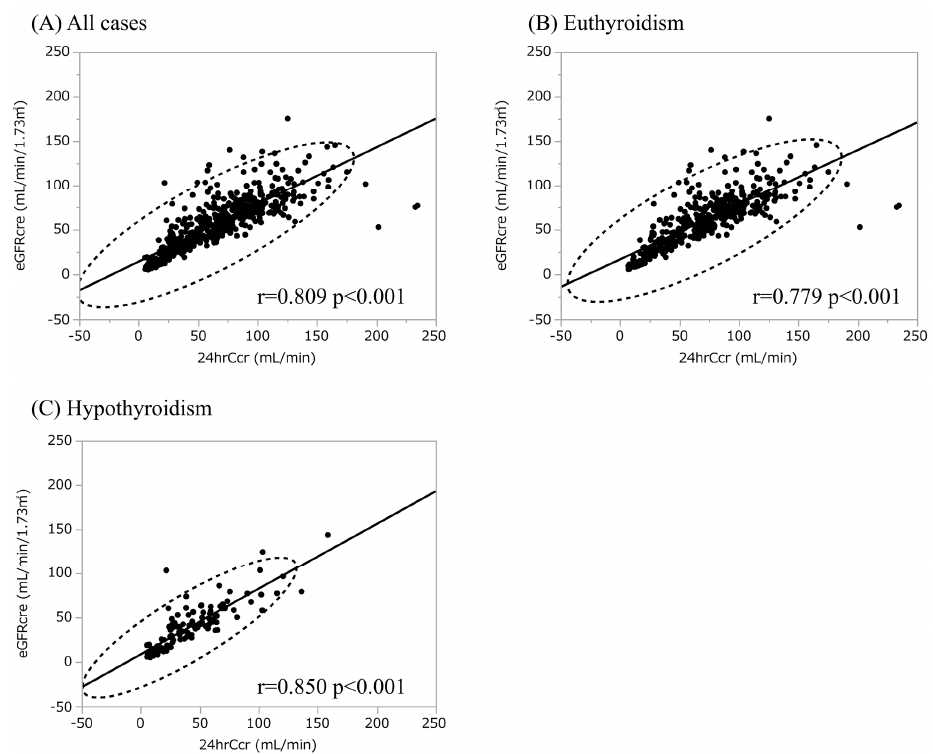
Figure 3. The association between eGFRcre and 24hCcr. ( A ) The association between eGFRcre and 24hCcr in all cases. ( B ) The association between eGFRcre and 24hCcr in euthyroid cases. ( C ) The association between eGFRcre and 24hCcr in total hypothyroid cases. eGFRcre, estimated glomerular filtration rate calculated by serum creatinine; 24hrCcr, 24 h creatinine clearance.